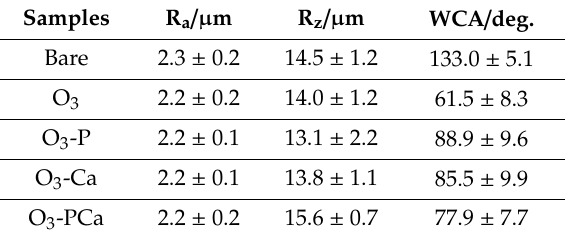
Figure 4. SEM images of the samples. Scale bars are 20 μ m. Bare: untreated PEEK, O 3 : ozone-gas-treated PEEK, O 3 -P: phosphate-immobilized PEEK, O 3 -Ca: calcium-immobilized PEEK, O 3 -PCa: phosphate and calcium co-immobilized PEEK. Table 2. Surface roughness and water contact angle of PEEK surfaces.